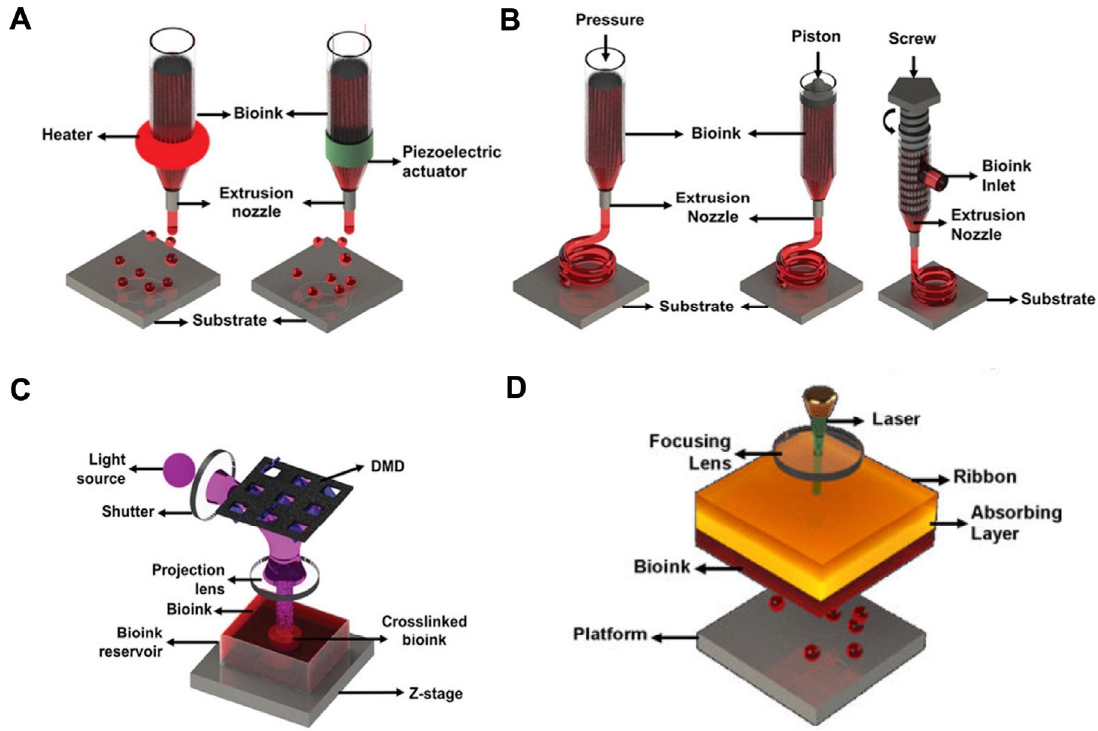
Figure 1. Schematic representation of four bioprinting methods [33]. ( A ) Inkjet-based bioprinting. ( B ) Extrusion-based printing. ( C ) Stereolithography-based bioprinting. ( D ) Laser-assisted bioprinting.